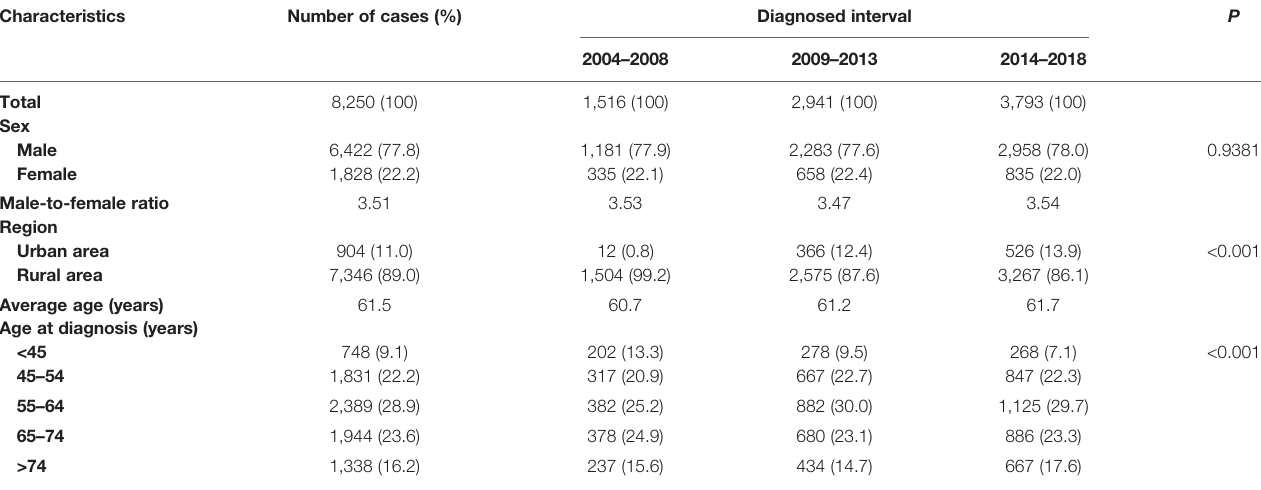
TABLE 1 | Basic characteristics of liver cancer patients diagnosed during 2004 – 2018 in Taizhou, eastern China. Characteristics